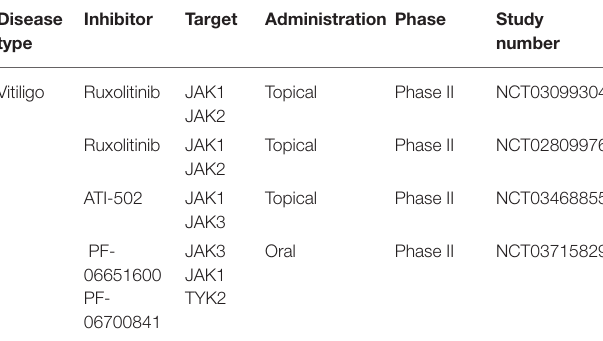
TABLE 10 | Clinical trials on JAKi for treating patients with vitiligo according to